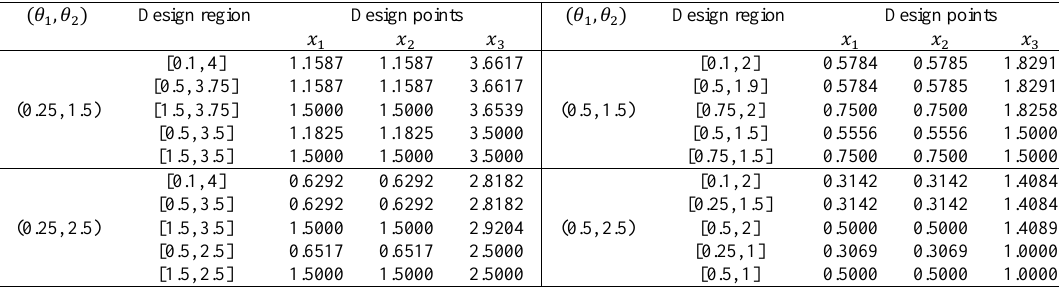
Table 5. A-optimal designs for generalized Pareto model with three support points having